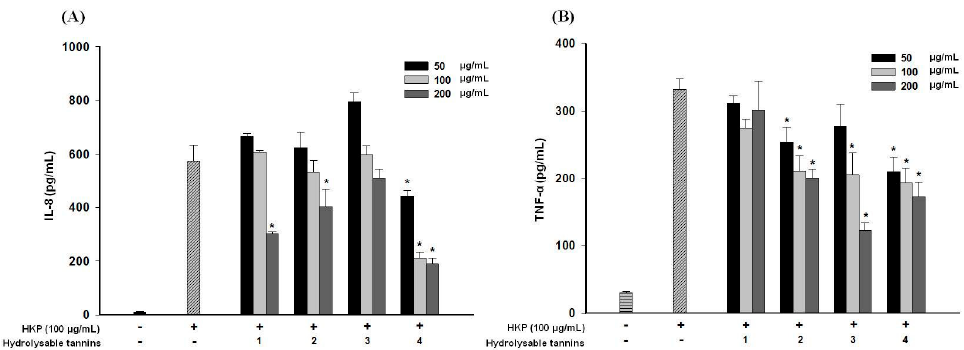
Figure 7. Anti-interleukin (IL)-8 ( A ) and tumor necrosis factor (TNF)- α ( B ) release from THP-1 cells after heat-killed P . acnes (HKP) induction; * p < 0.05, compared to the HKP-only group; Data are presented as the mean ± SD; Significance was calculated using a one-way analysis of variance (ANOVA) by SPSS software v.15; Data are from three repeats.